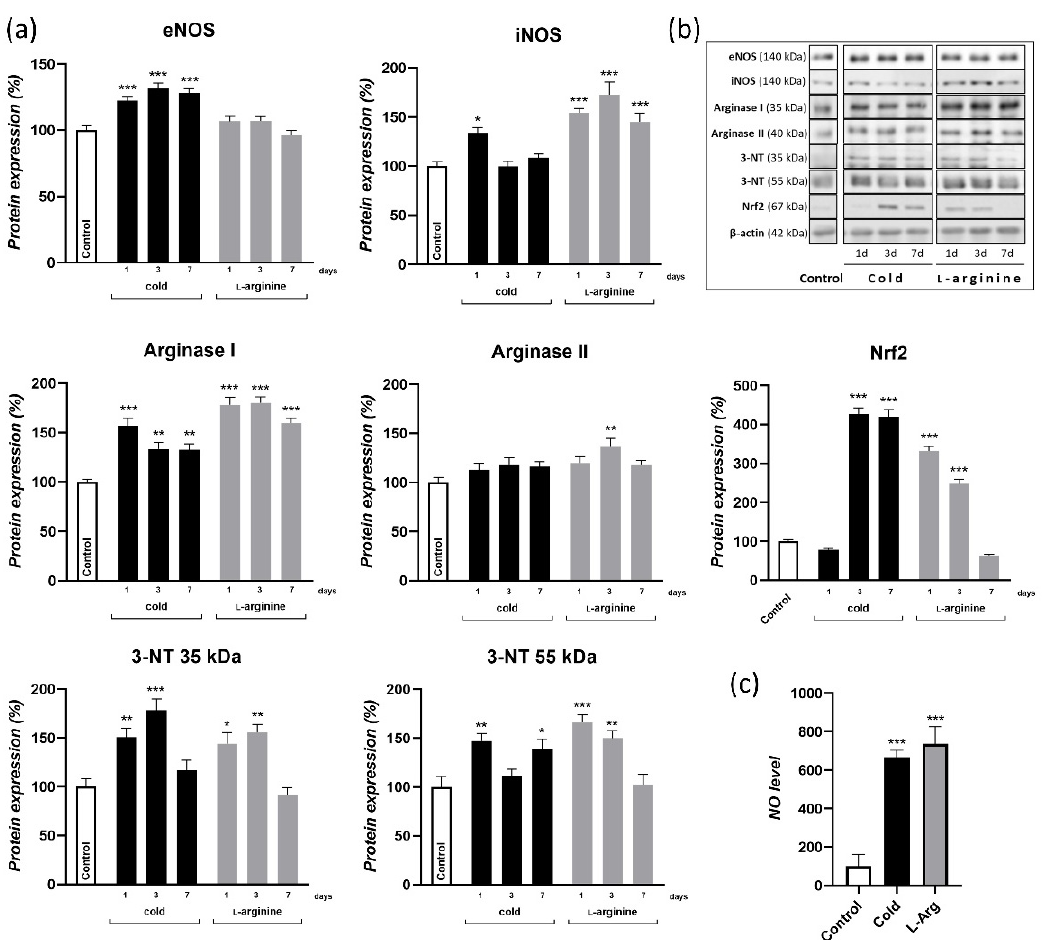
Figure 1. Induction of L -arginine/NO pathway in rpWAT of cold-exposed rats and the effects of 2.25% L -arginine supplementation. Protein expression analysis of endothelial NO synthase (eNOS), inducible NO synthase (iNOS), arginases I and II, nuclear factor-erythroid factor 2-related factor 2 (Nrf2), and 3-nitrotyrosine (3-NT)-modified proteins (represented by two-immunoreactive bands, at 35 and 55 KDa) during 1, 3, and 7 days of cold exposure and L -arginine treatment ( a ) and their corresponding blots ( b ). Each band is representative of six pooled samples per group. Protein content is expressed relative to control acclimated to room temperature (100%). Experiments were repeated in triplicate. Data were quantified as described in the Methods. ( c ) Detection of nitric oxide (NO) levels in the mature adipocytes stimulated by L -arginine (300 μ M) for 30 min, at 37 °C, previously isolated from rpWAT of untreated (control), cold-exposed, and L -arginine (2.25%)-treated rats for 7 days ( n = 9, 3 per group, in three technical replicates per group). Data represent the mean ± SEM. * Compared to control, * p < 0.05, ** p < 0.01 and *** p <